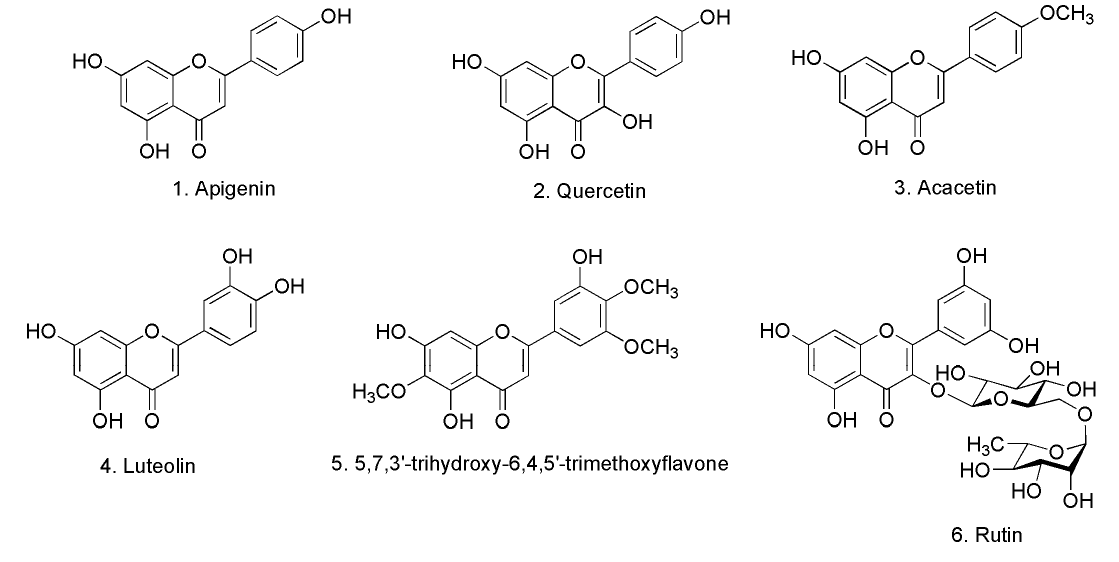
Figure 1. Chemical structures of the isolated compounds from LCA.